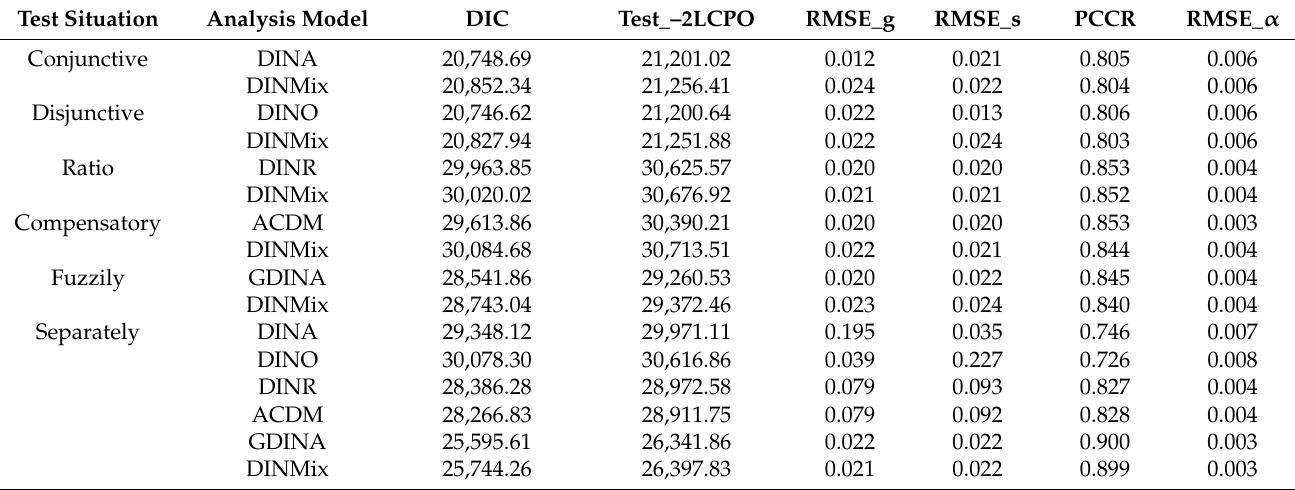
Table 3. Summary of the Results of Simulation Study